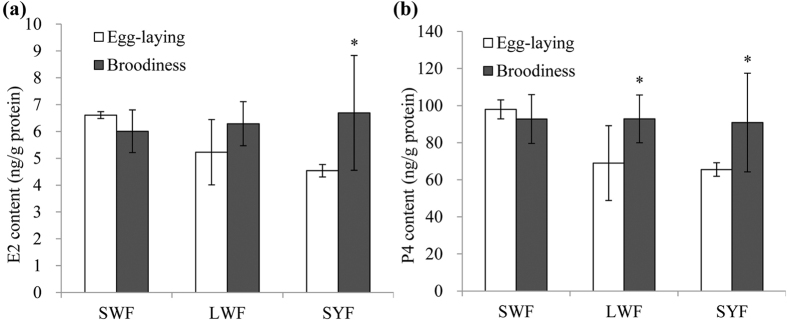
Contents of reproductive endocrine hormones, including E2 (a) and P4 (b) of SWF, LWF and SYF from egg-laying and broody geese. *Values significantly different (P < 0.05) from those in egg-laying geese.